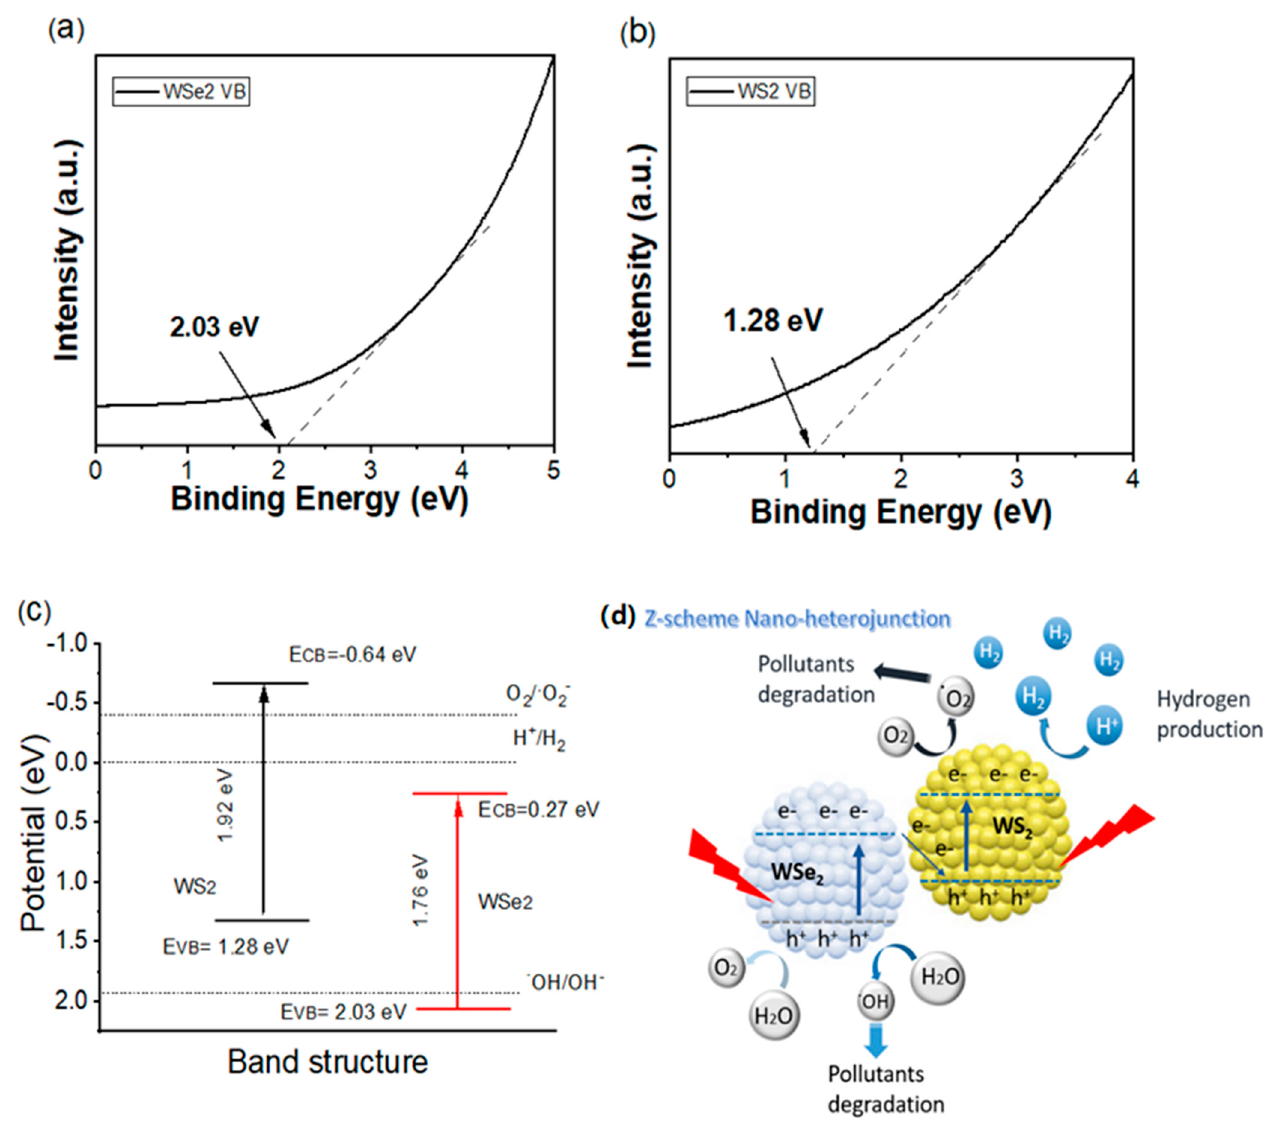
Figure 6. UPS spectrum ( a ) WSe 2 , ( b ) WS 2 , and ( c ) band structure diagram of WS 2 /WSe 2 , ( d ) Schematic diagram of the proposed Z-Scheme photoelectron mechanism of WS 2 /WSe 2 photocatalytic system under visible light illumination.